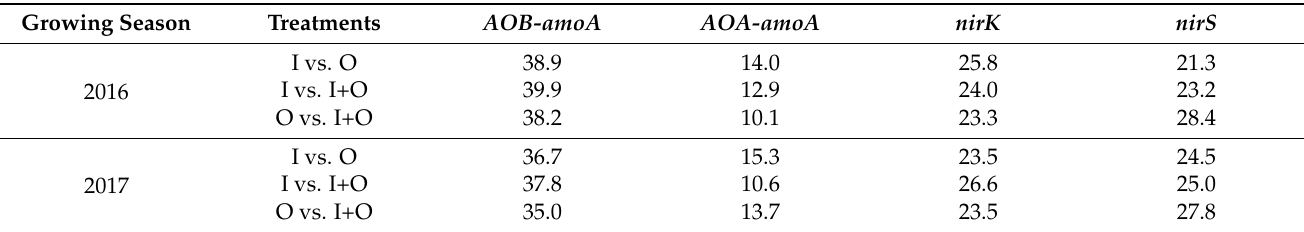
Table 3. Respective contribution of each nitrifier ( AOB-amoA and AOA-amoA ) and denitrifier ( nirK and nirS ) gene to community abundance variations (%) among fertilization treatments during two growing seasons of purple